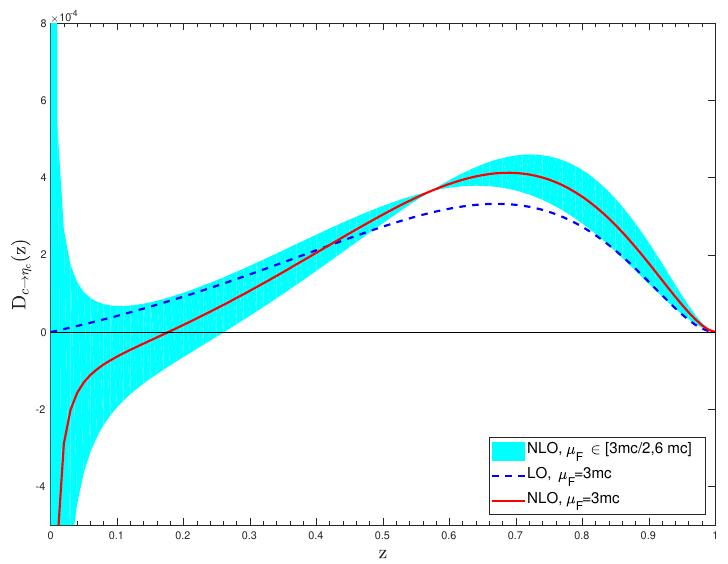
( z, µ F ) as a function of z up to LO and NLO accuracy, c